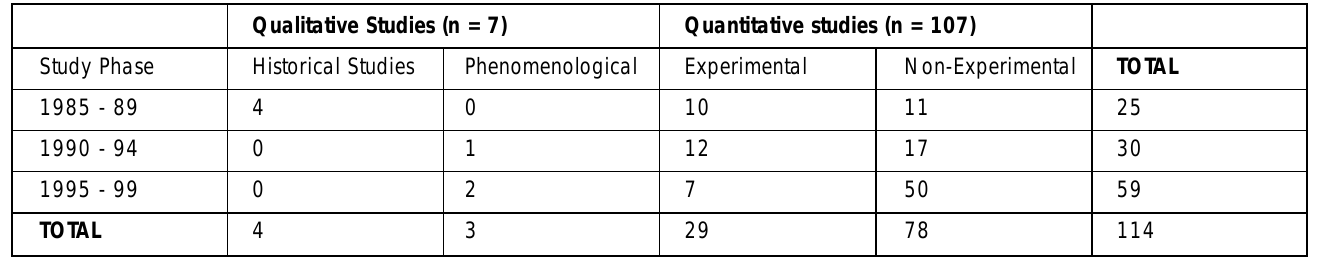
Table 1: Methodological Trends